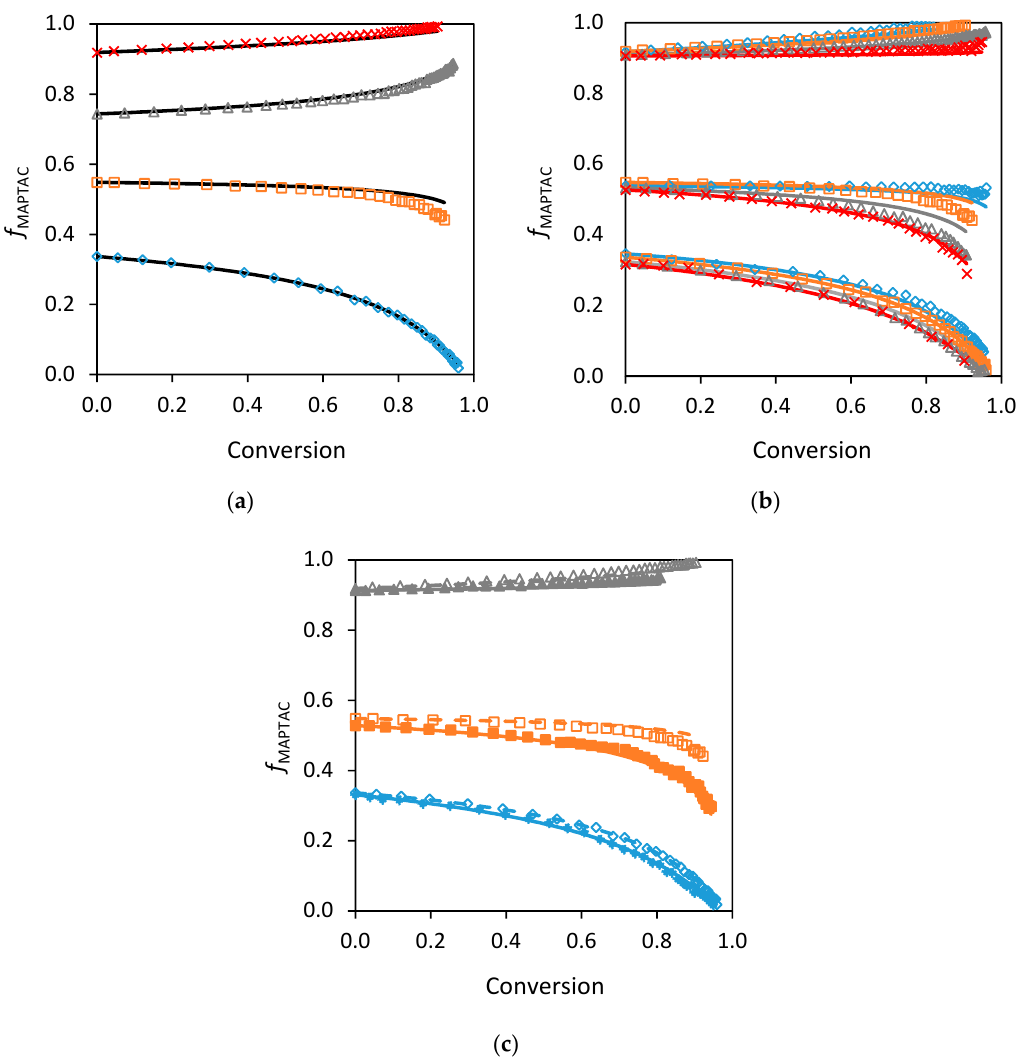
Figure 8. Comparison of batch comonomer composition drifts for AA-MAPTAC copolymerizations at 50 °C and 0.80 wt% V-50 at different initial monomer compositions with ( a ) w mon,0 = 0.10; ( b ) w mon,0 = 0.05( ◊ ), 0.10( □ ), 0.20( Δ ) and 0.40(×) at di ff erent initial monomer compositions; and ( c ) for w mon,0 = 0.10 without (open symbols) and with 1.0 mol · L − 1 NaCl (closed symbols). Lines are model representations of the composition drift